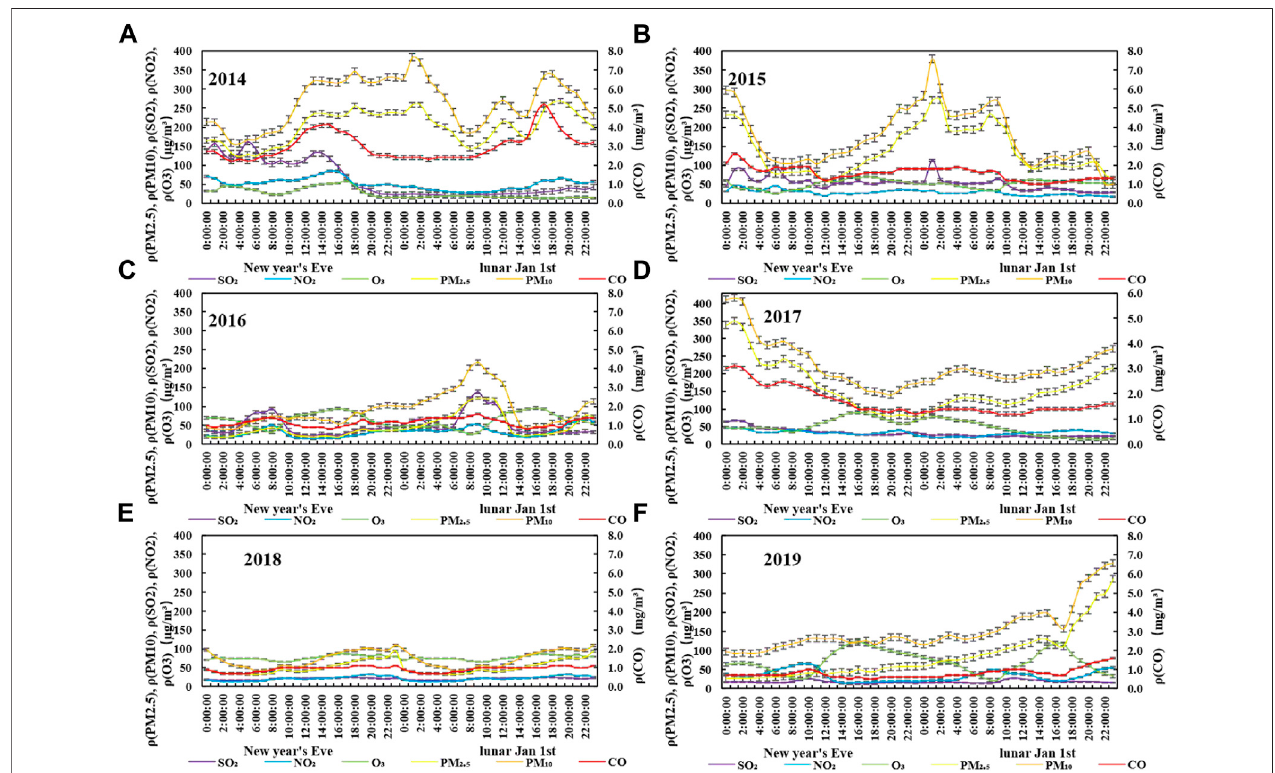
FIGURE 5 | Hourly variation of the average concentration of main pollutants from New Year ’ s Eve to the 1st January in 2014 – 2019.